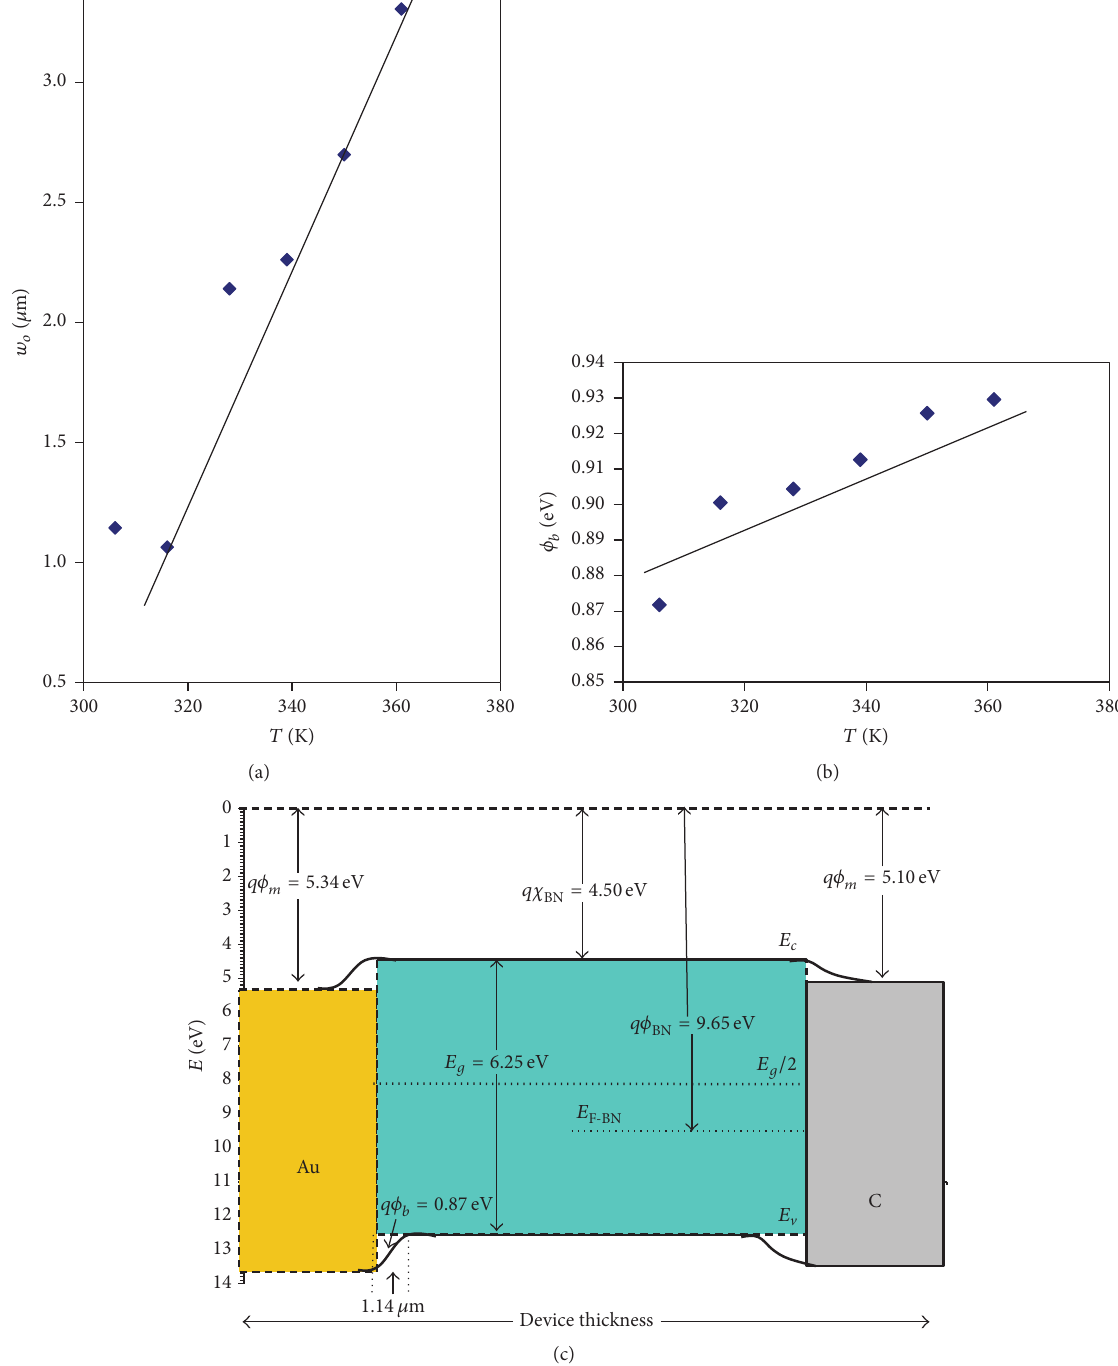
Figure 3: The temperature dependence of (a) the depletion region width and (b) the barrier height of the Au/BN/C device. (c) The energy , and 𝐸 𝑔 are the metal work function, electron affinity, barrier height, band diagram of the device. In the diagram 𝜙 𝑚 , 𝑞𝜒 , 𝑞𝜙 𝑏 , 𝐸 𝑐 , 𝐸 V , 𝐸 F - BN conduction band energy level, valence band energy level, the Fermi level of BN, and the energy band gap,